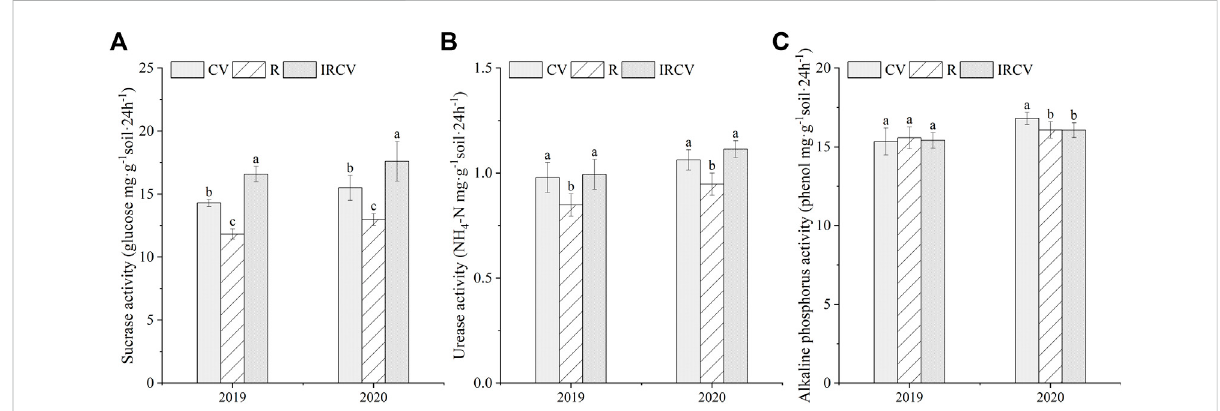
FIGURE 3 Changes in soil enzyme activities under the three cropping systems in 2019 – 2020. Different lowercase letters represent signi fi cant differences among treatments ( p < 0.05). Soil sucrase (A) , urease (B) , and soil alkaline phosphatase (C) . CV, R, and IRCV represent common vetch monoculture, rape monoculture, and R and CV intercropping, respectively.